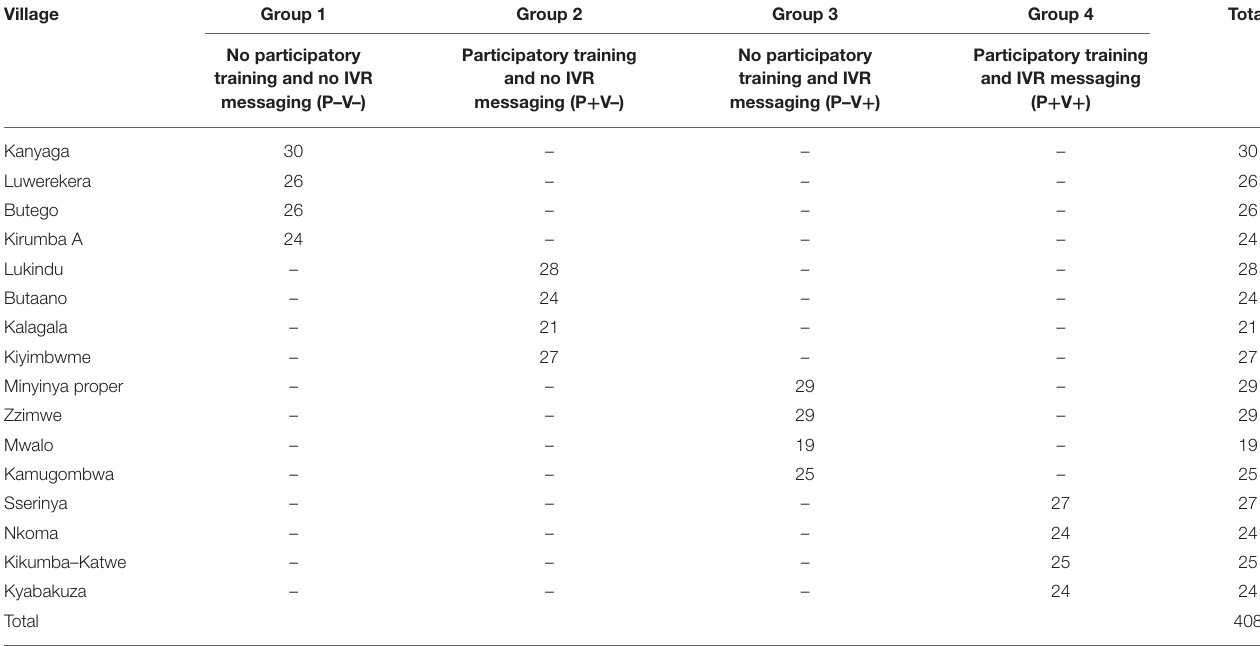
TABLE 1 | RCT arms and actual numbers of farms/households who have participated in the study.